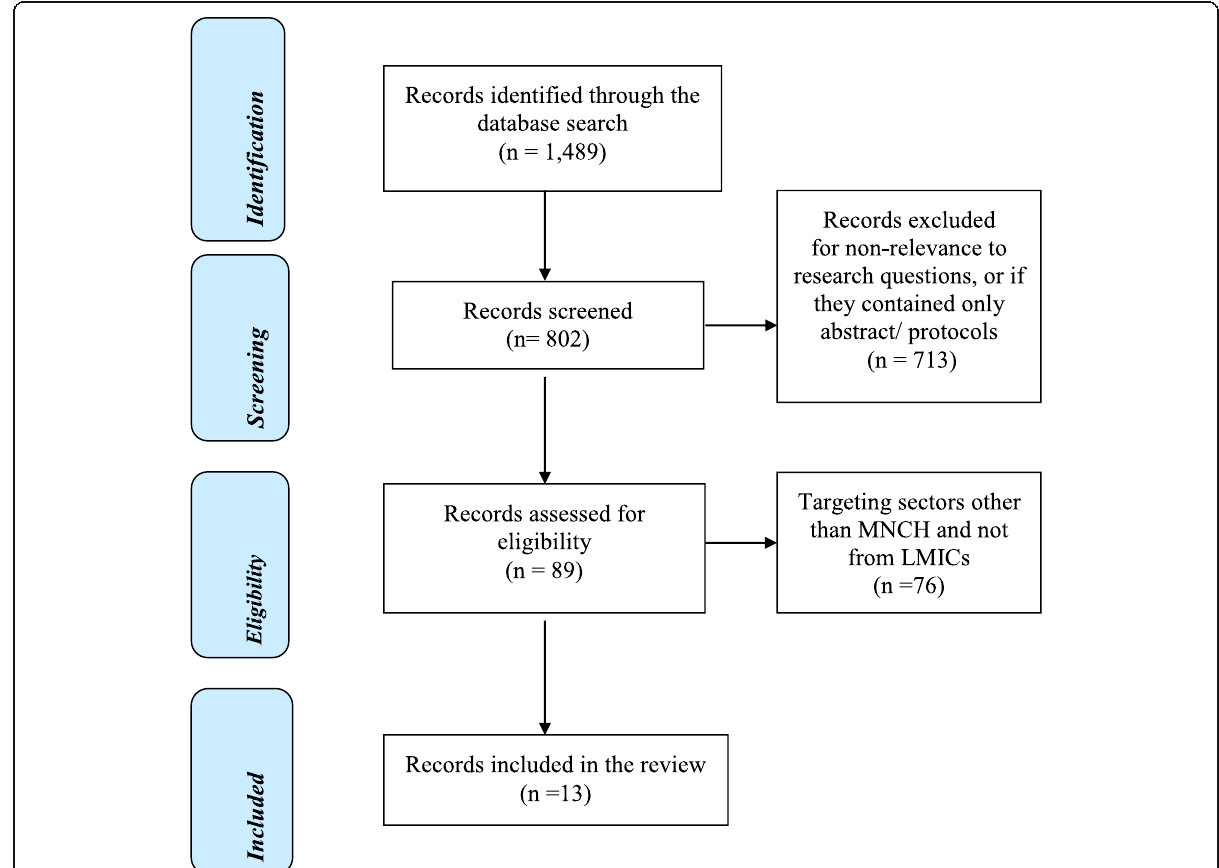
Fig. 1 PRISMA flow diagram for the evidence on RBF mechanisms on maternal, neonatal, and child health in low- and middle-income